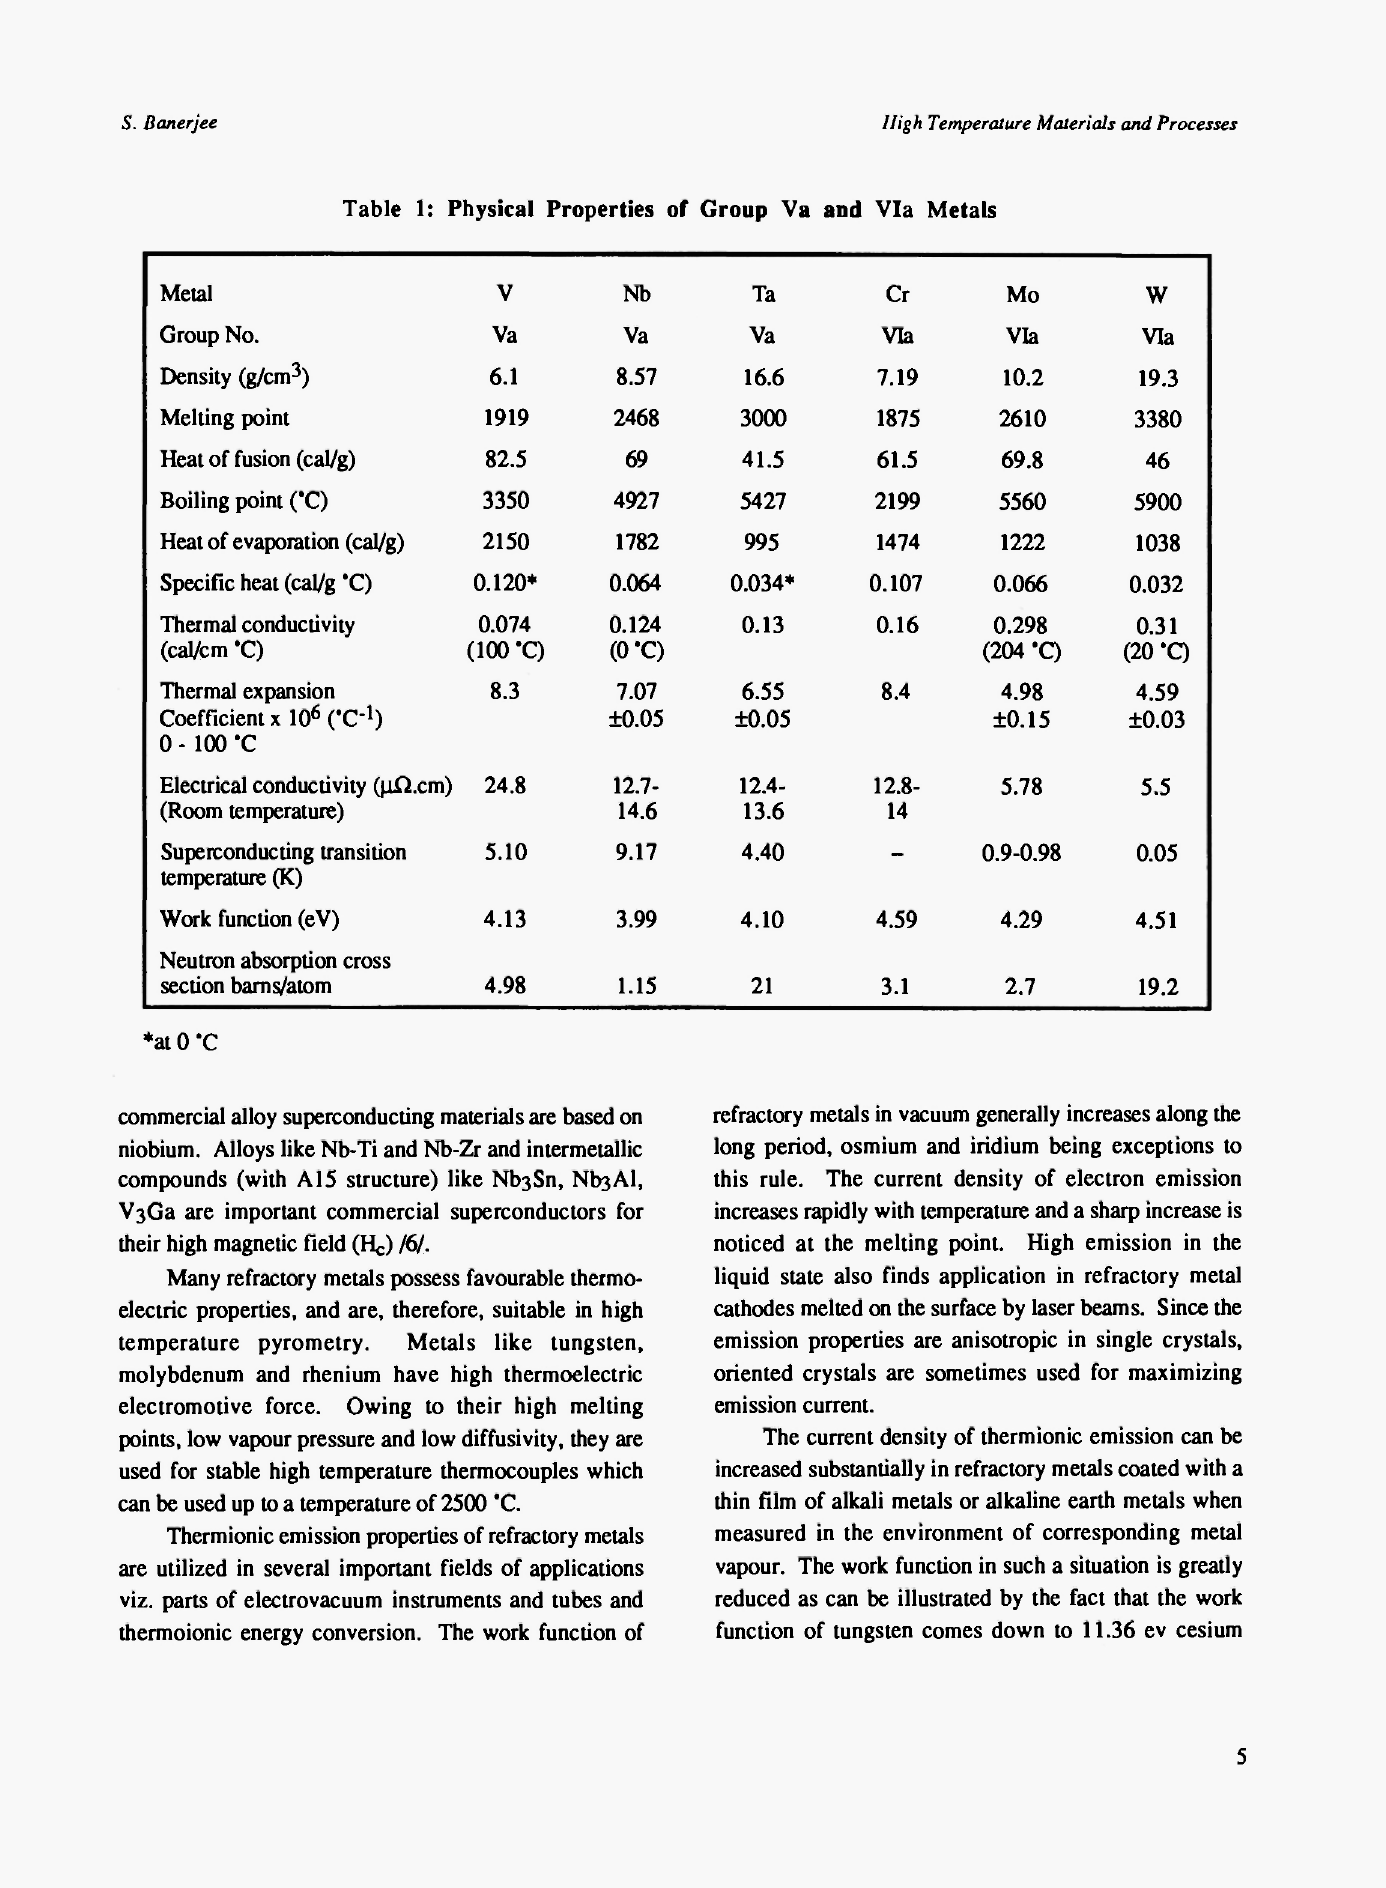
Table 1: Physical Properties of Group Va and Via